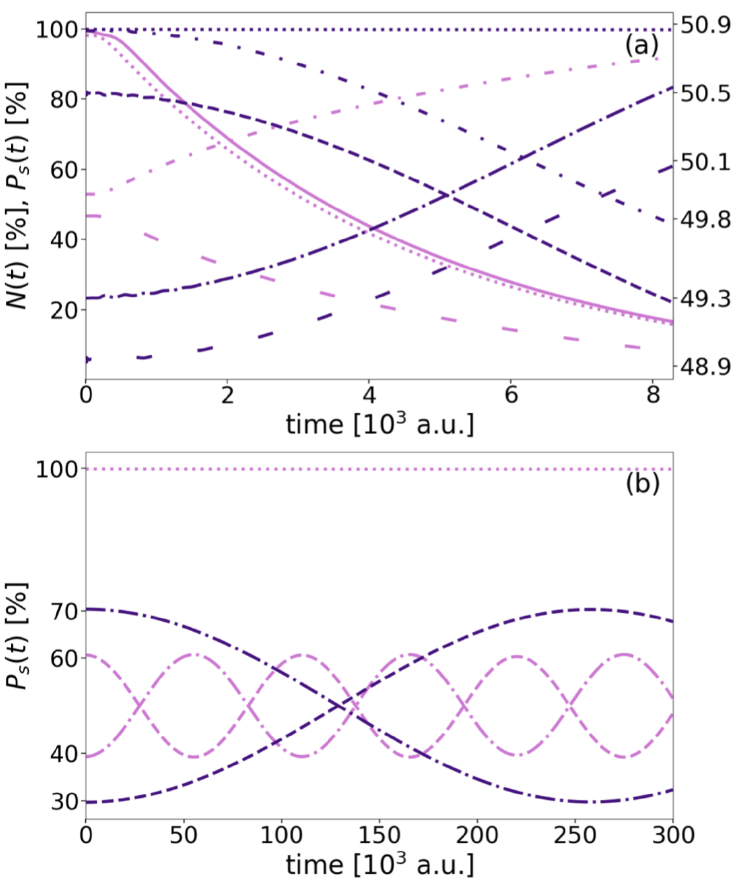
Figure 12. Single-state populations P S ( t ) (interrupted lines) and norm N ( t ) (solid) in % as function of the propagation time for the SE decay. In ( a ) the left ordinate and light purple lines belong to R AB = 10a.u., whereas dark purple lines and the right ordinate correspond to R AB = 13a.u. In ( b ) projections corresponding to R AB = 21a.u. (34.a.u.) are indicated in light (dark) purple. The five individual states examined are A ∗ (dashed), A (dashed-dotted), each tight or loosely for right or left QD in ( a ), and B